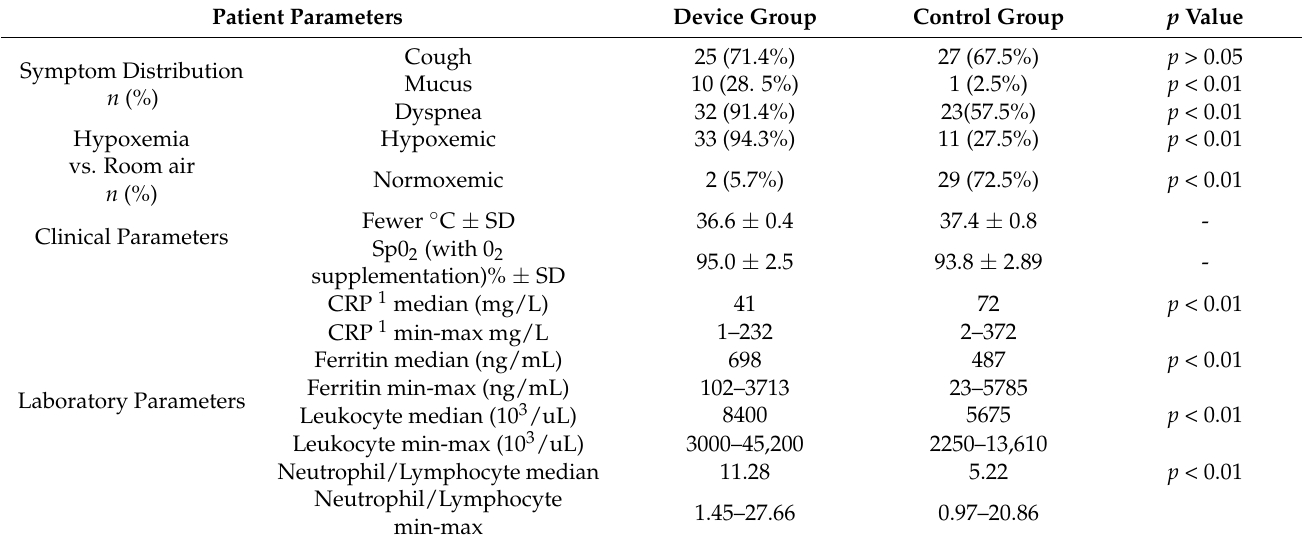
Table 5. Patient Parameters in Device and Control Groups.